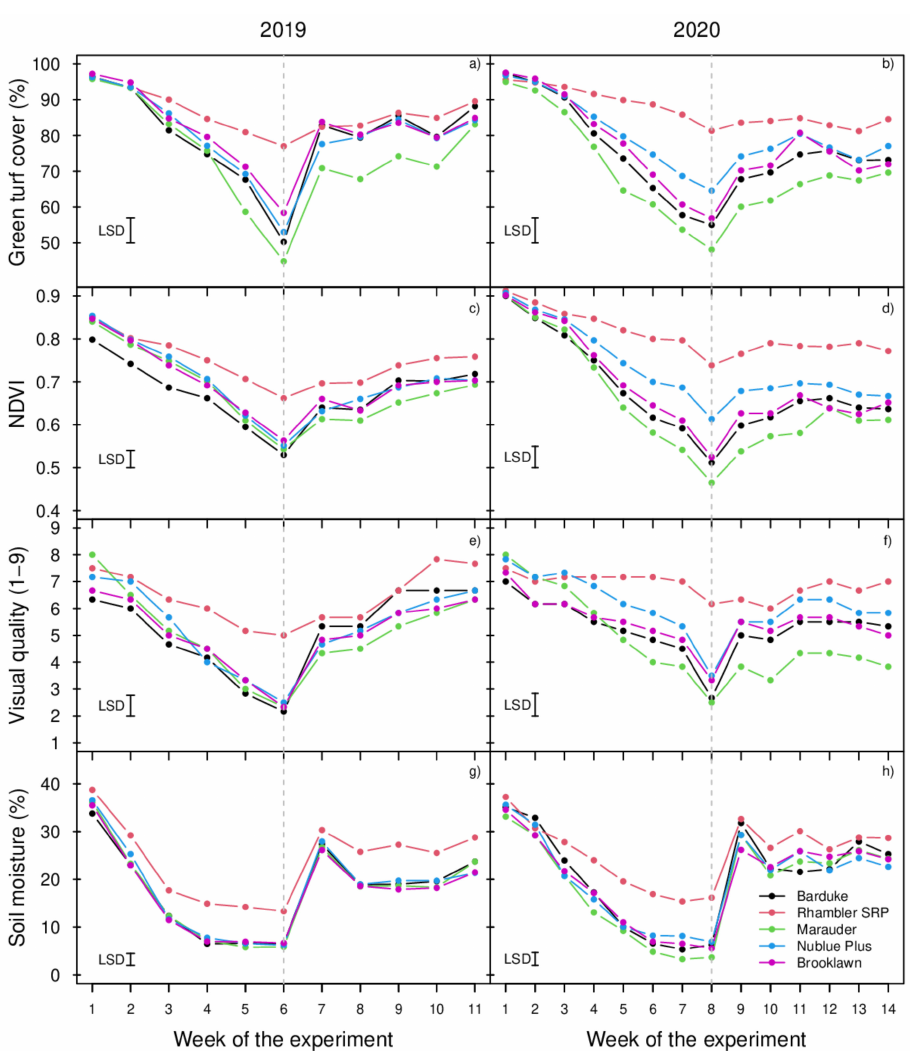
Figure 2. The effects of the sampling date on green turf cover ( a , b ), NDVI ( c , d ), visual quality ( e , f ), and soil moisture ( g , h ) in 2019 (on the left) and 2020 (on the right) of the four Kentucky bluegrass cultivars (‘Barduke’, ‘Marauder’, ‘NuBlue Plus’ and ‘Brooklawn’) and the tall fescue cultivar ‘Rhambler SRP’. In all the graphs, the grey dashed line separates the drought phase on the left from the recovery phase on the